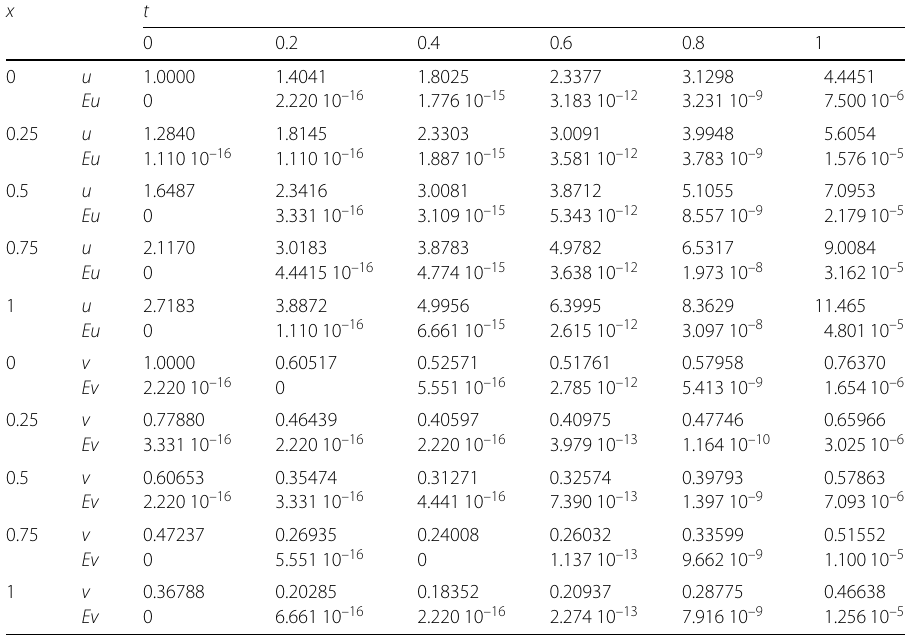
Table 2 Solution and residual error for Example 3 when α = 0.7 and β = 0.5 at several values of x and t using 60 terms of the series ( (cid:2) = –0.85)